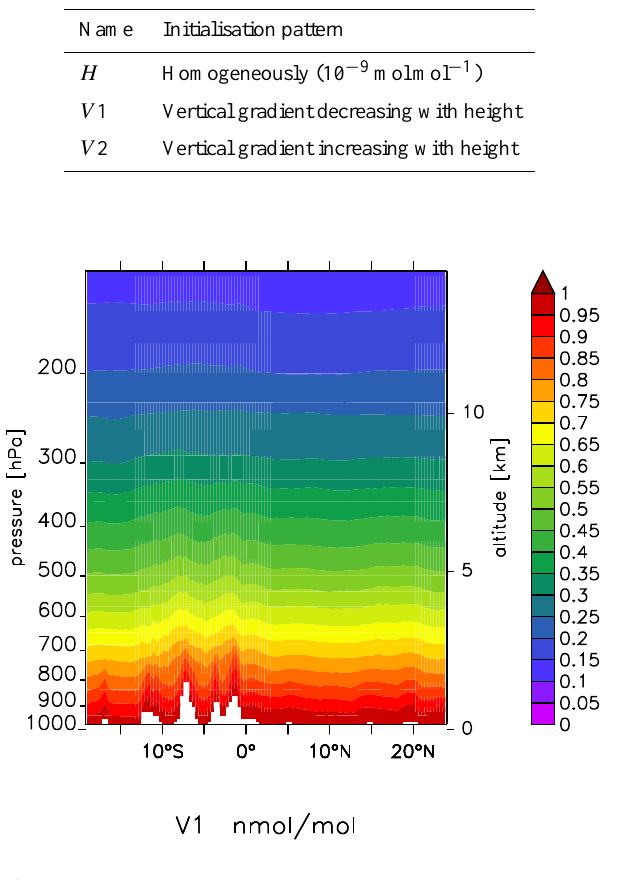
Fig. 4. Initialisation pattern of the passive tracer V 1 . The horizontal axis shows rotated coordinates.